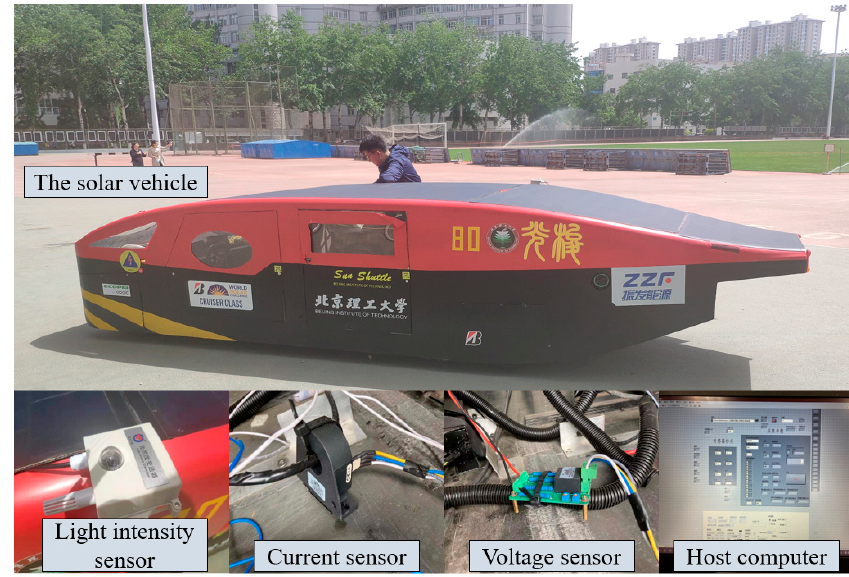
Figure 11. Physical test platform. Table 3. Specifications of test equipment.